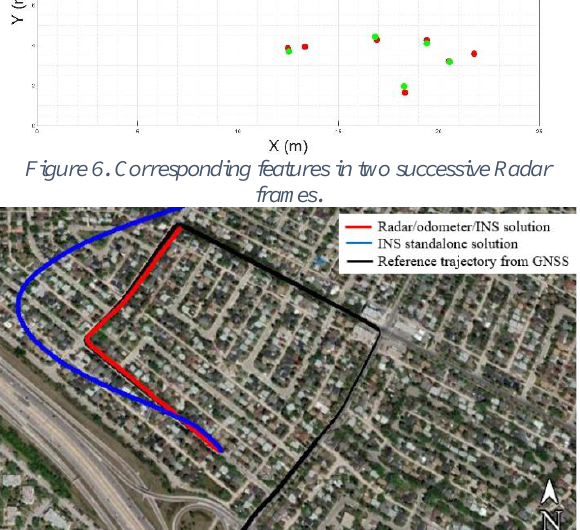
Figure 7. The estimated trajectory of the second test from Radar/odometer/INS integration during a simulated GNSS outage for 1-minute versus the reference trajectory from GNSS and the estimated trajectory from INS standalone solution.